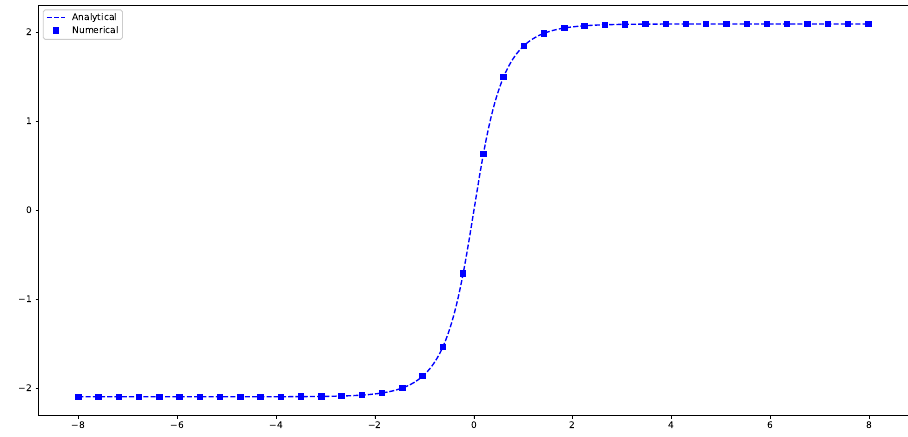
Figure 15 . The comparison of the analytical (4.50) and numerically generated kink Φ( x ) for the parameters θ 0 = 2 π , β = 1 , κ = 1 , M = 1 3